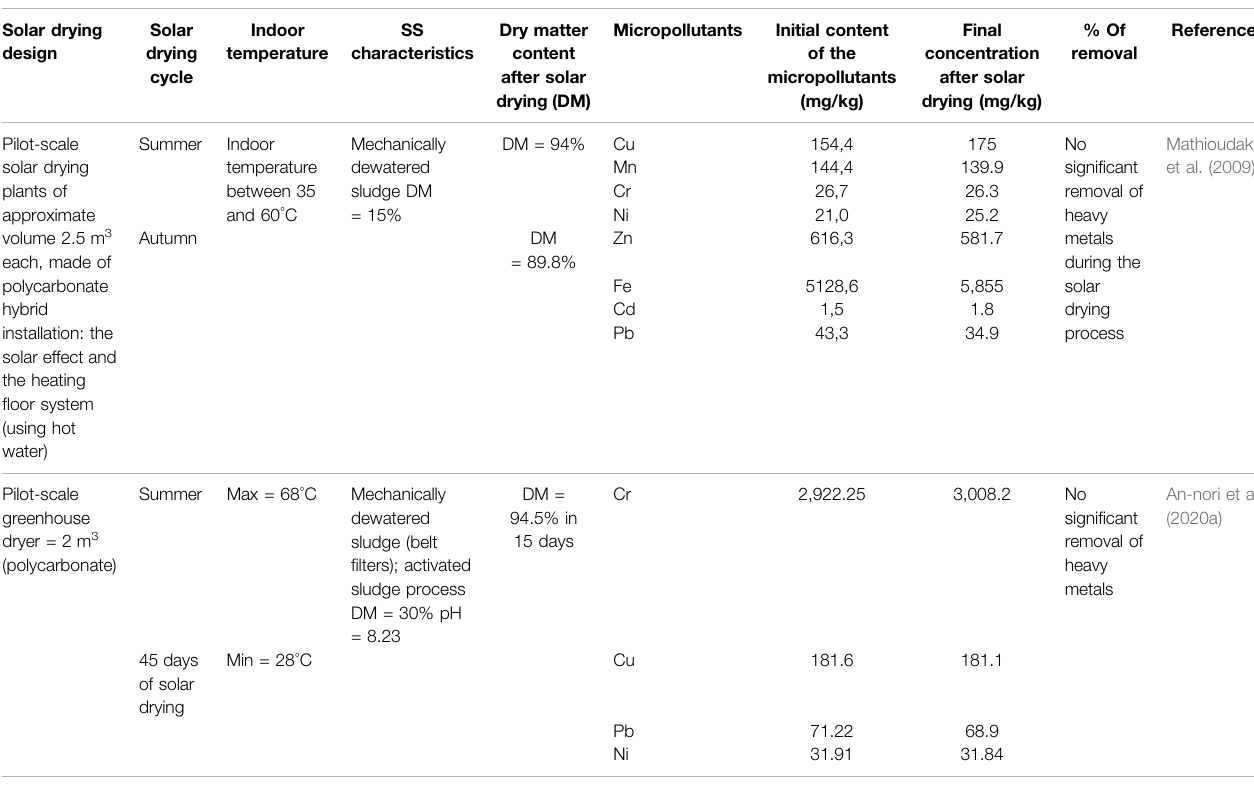
TABLE 9 | Impact of solar drying on heavy metals in